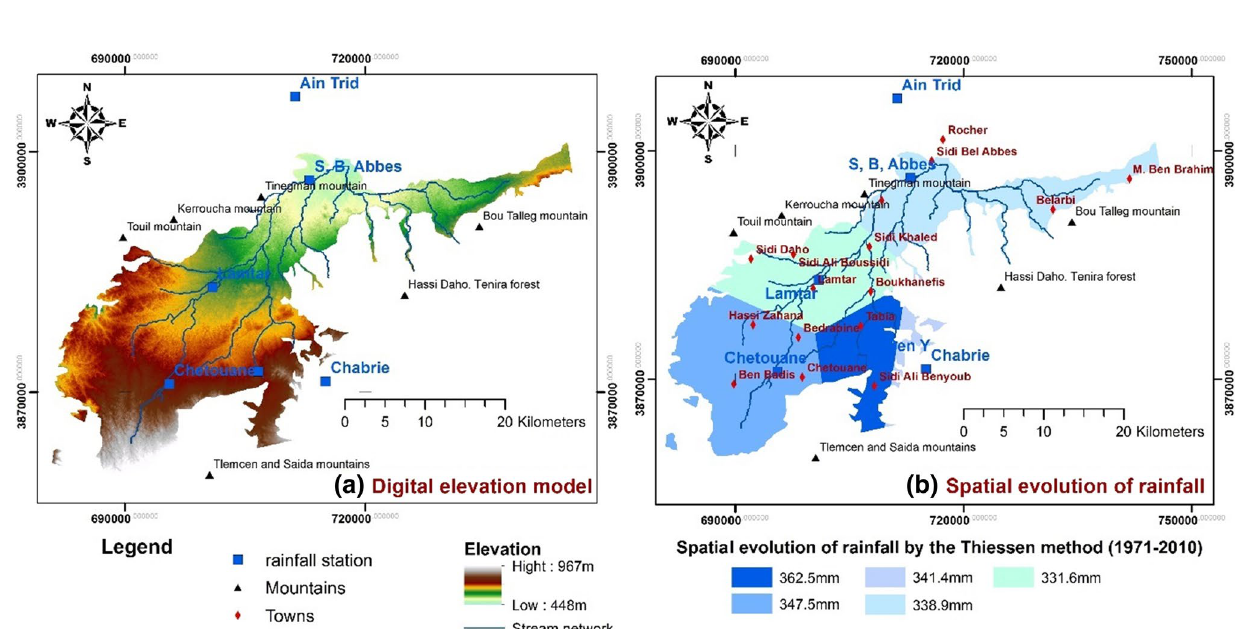
Fig. 3 Spatial distribution of precipitation over the 1971–2010